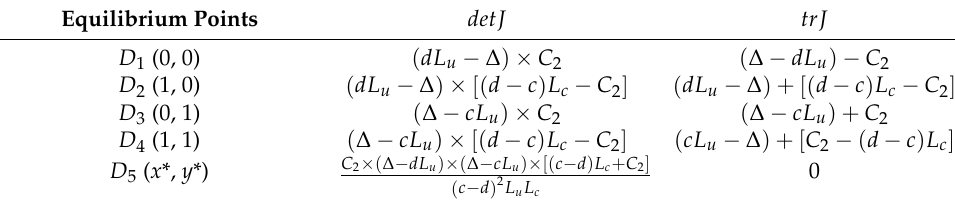
Table 3. Determinant and trace of the Jacobian